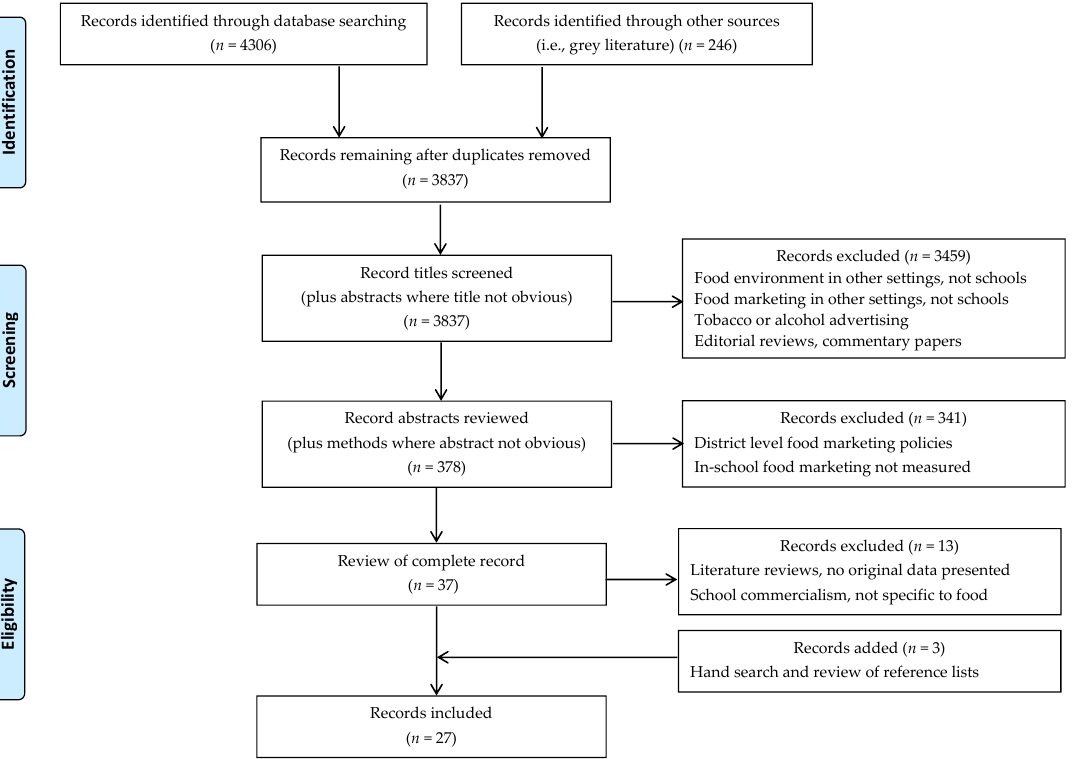
Figure 1. Flow diagram of records identified through